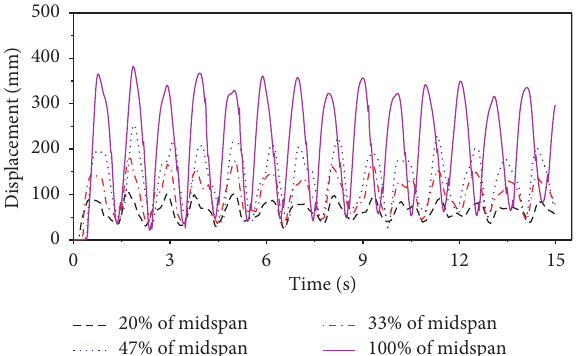
Figure 5: Displacement-time history curve of the midpoint of ice-shedding span under different ice-shedding quantities (VI ∼ IX).